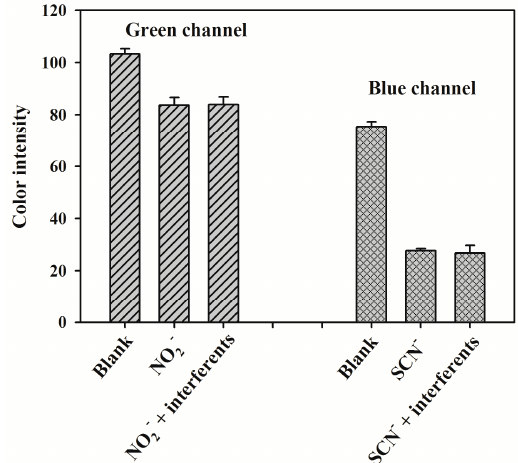
Figure 9. The specificity of the fabricated 3D sl- µ PADs. The concentrations of nitrite and thiocyanate are 0.5 and 5 mM, respectively. The concentrations of the interferents are all 50 mM. Error bars represent the standard deviation of four parallel experiments.